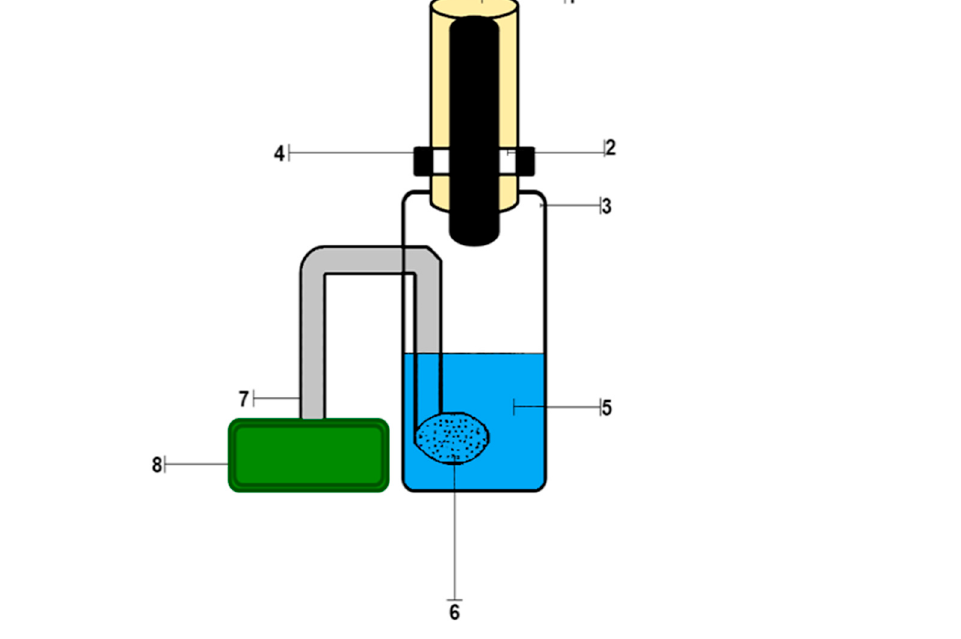
Figure 2. Setup for dynamic gas extraction: 1—rubber stopper; 2—test strip; 3—glass vessel for the analyzed solution; 4—holder of test strips; 5—reaction mixture; 6—glass bubbler; 7—polymer hose; 8—air microcompressor.